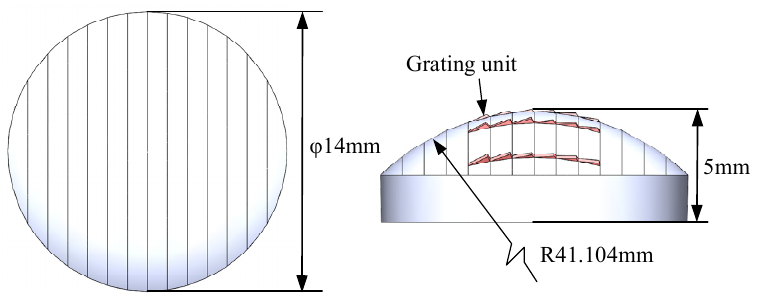
Figure 3. Workpiece size of convex spherical blazed grating. Table 1. Specifications of convex spherical grating.